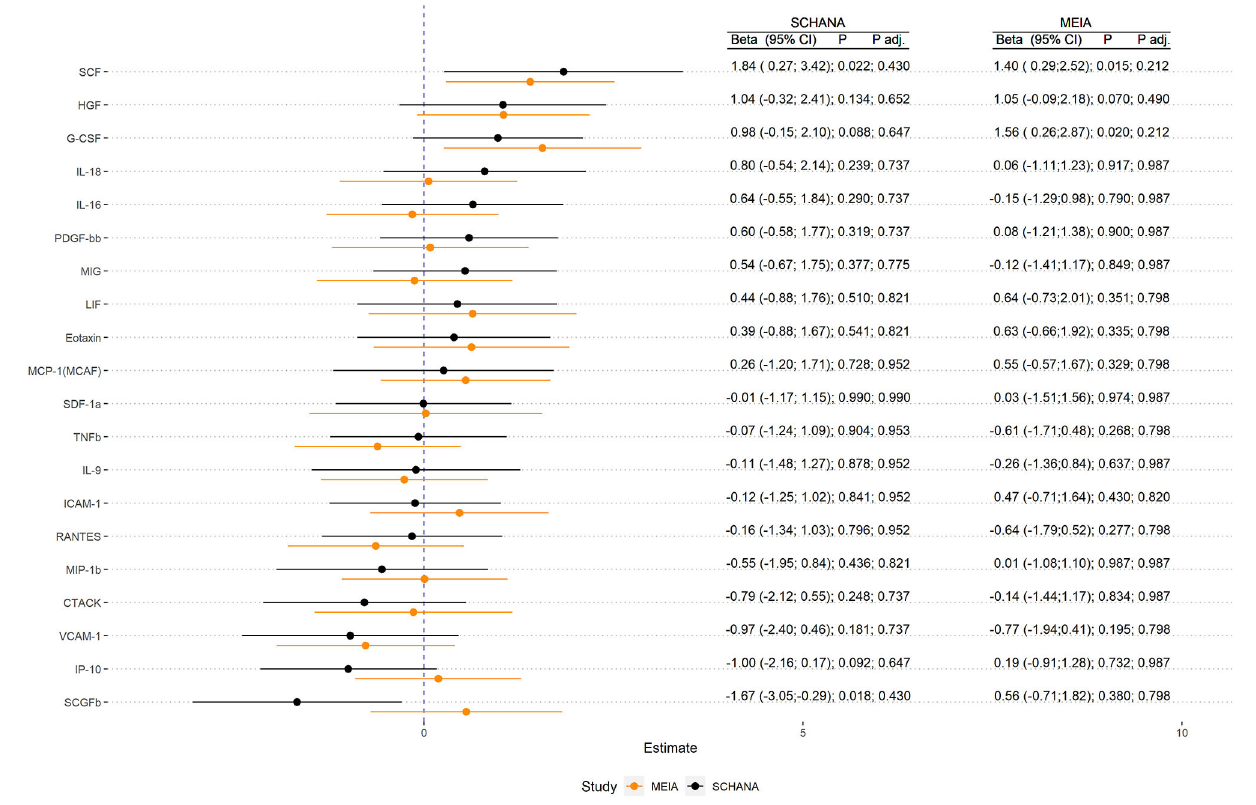
G-CSF with fatigue in the MEIA sample ( ß = 1.56, 95% CI